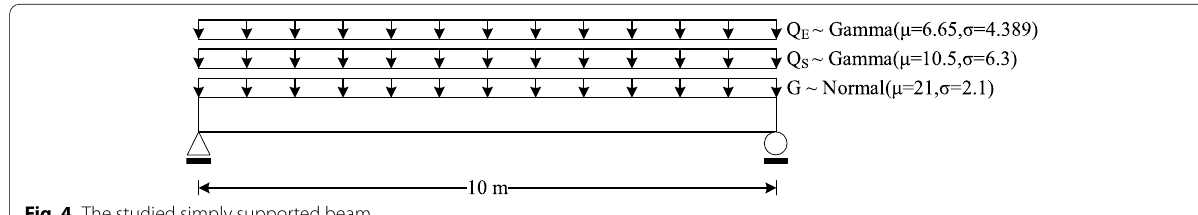
Fig. 4 The studied simply supported